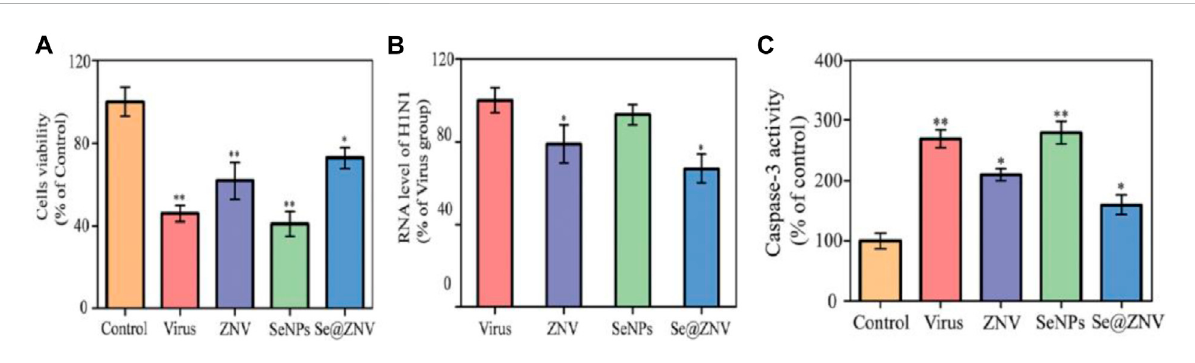
FIGURE 5 (A) Antiviral activitythroughcell viability percentage. (B) PercentageoftheRNAlevel of H1N1. (C) Caspase-3 activityof infected MDCK cells(Lin et. al.,